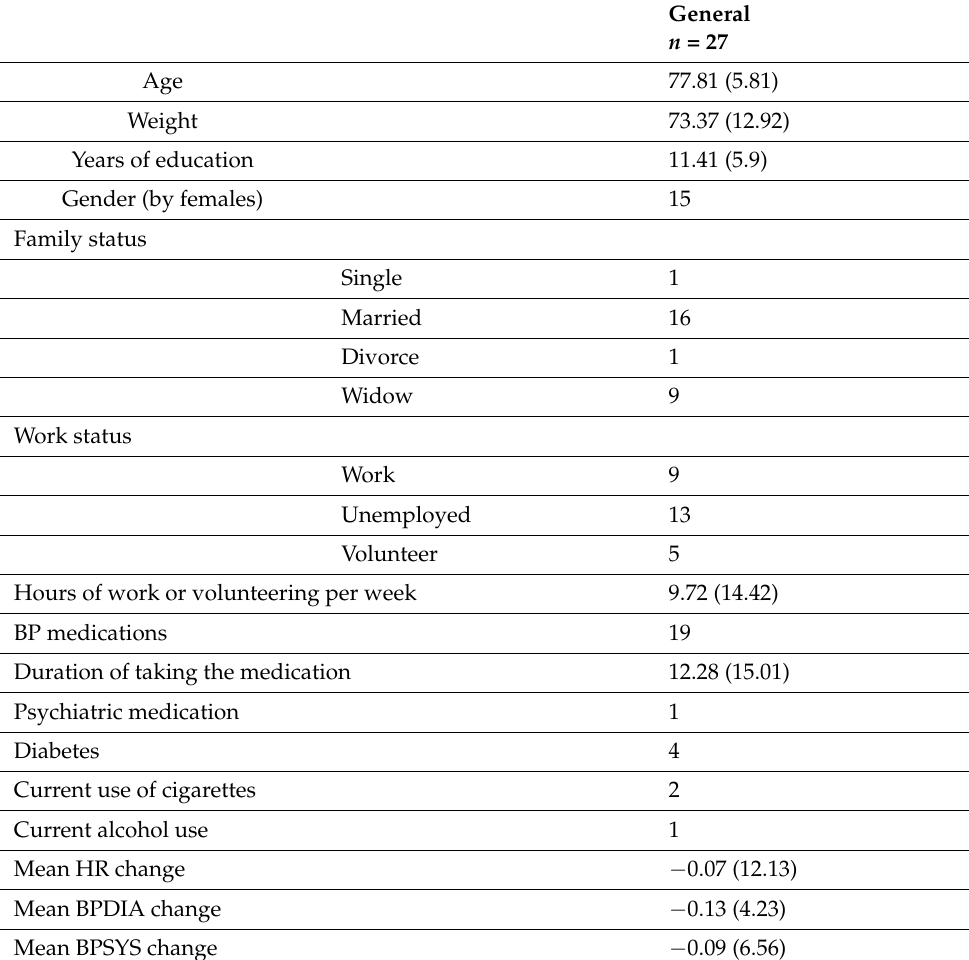
Table 7. Experience 2—demographic